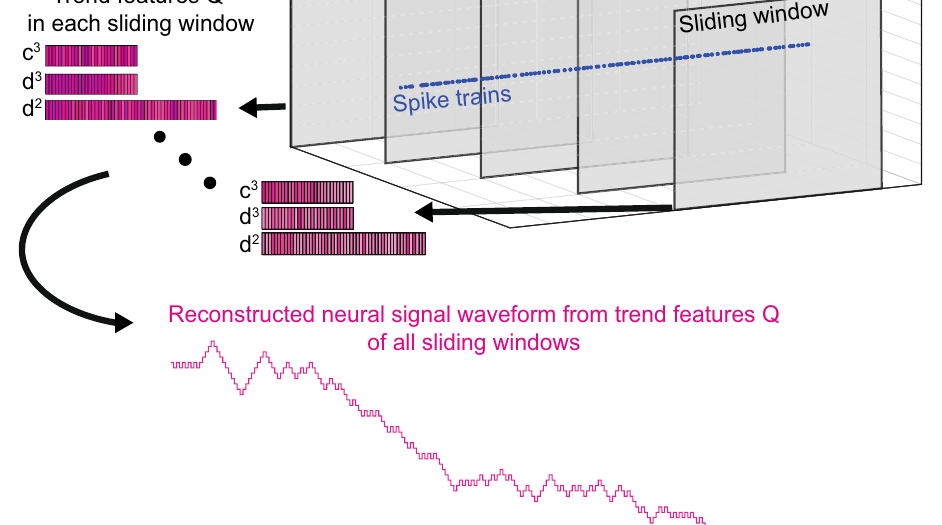
Figure 3. ( a ) Comparison between neural signal waveform and spike counts. There are 10 bins (gray). The size of each bin is 50ms. The time resolution of spike trains (blue) is 5ms. The spike counts (black square waves with the number of spikes on top of it) in each bin ignore the temporal patterns of spike events (e.g., bin 3 and bin 4 have the same number of spikes, but the distributions of spike events are different). Neural signal waveform (pink) fluctuates with the distribution of spike events. ( b ) Temporal features Q capture the temporal patterns of spike trains since we can reconstruct neural signal waveform using encoded trend features Q (see Supplementary Fig. S1 for more information about reconstruction). Each neural signal waveform in each sliding window is encoded into trend feature Q. BMI decoders can better decode kinematics using trend features Q than that of BMI decoders using spike